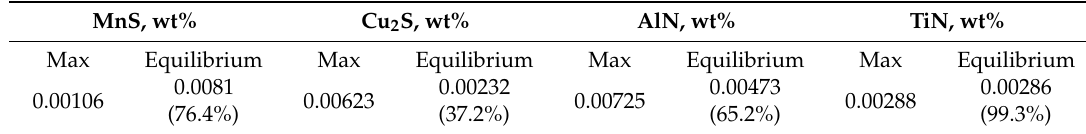
Table 2. Equilibrium precipitation amount at the soaking temperature.